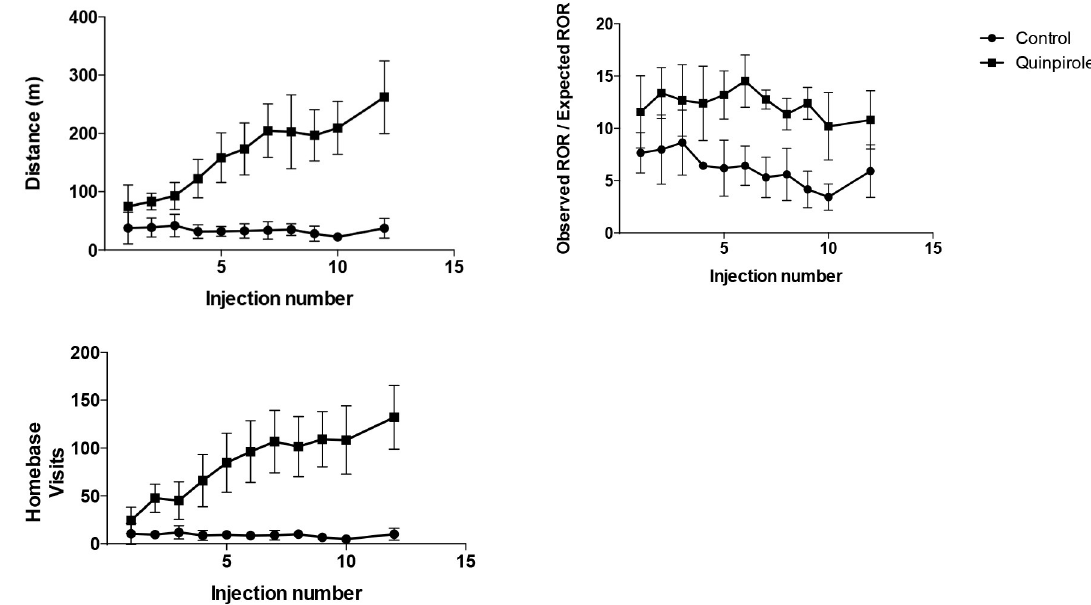
Fig 1. Open field test. The parameters of the Open Field Test (OFT)–distance, homebase visits and observed ROR/expected ROR–are plotted here over time. The changes on all parameters were significantly different (p < 0.05) between the two groups from injection 2 onwards. As injection 11 was combined with the cage experiment, animals were not exposed to the OFT on this day.